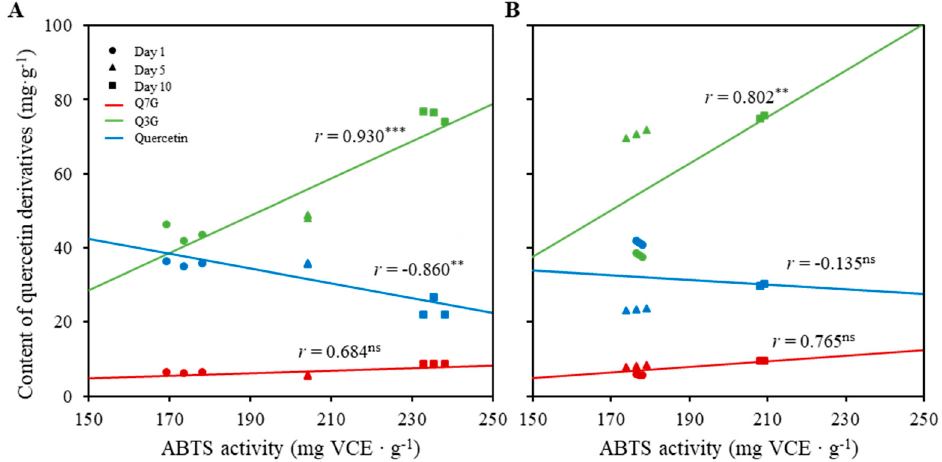
Figure 6. Correlation between ABTS radical scavenging activity and content of quercetin derivatives in 10 mM MeJA treatment without UV-B ( A ) and with 1 W · m − 2 · s − 1 UV-B ( B ). ns, **, and *** indicate no significance, significance at p < 0.01, and significance at p < 0.001, respectively, in Pearson correlation coefficient test.